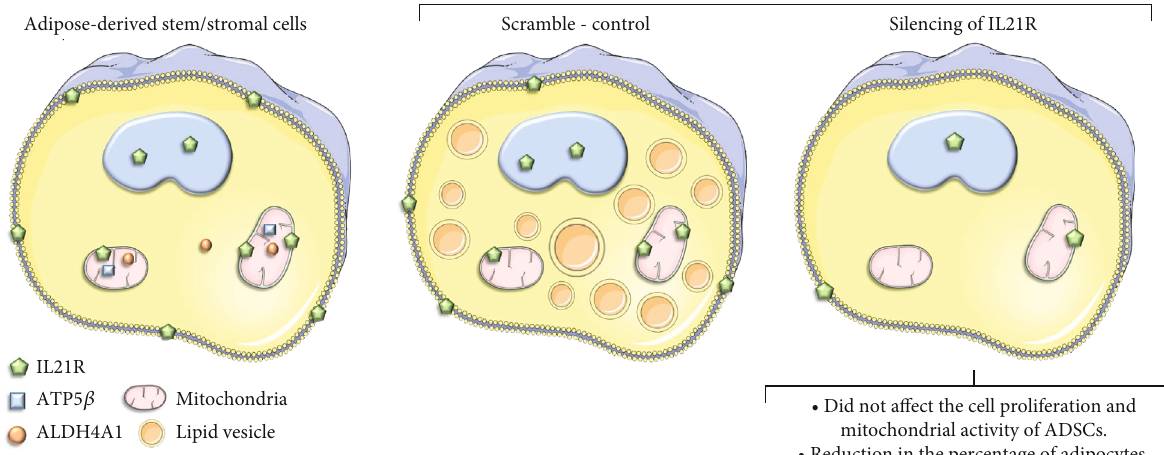
Figure 5: Schematic summary of fi ndings on the role of IL21R in ADSCs and adipogenesis. The images were obtained from the Servier Medical Art